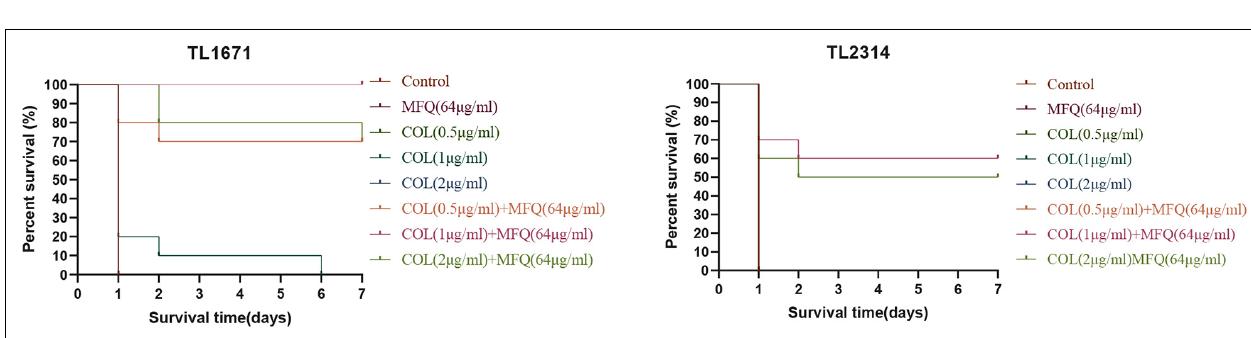
FIGURE 4 | Scanning electron microscopy image. TL2314 was selected as the experimental strain. (A) : LB broth control group, 3000 × ; (B) : LB broth control group, 7000 × ; (C) : mefloquine single group, 3000 × ; (D) : mefloquine single group, 7000 × ; (E) : colistin single group, 3000 × ; (F) : colistin single group, 7000 × ; (G) : mefloquine combined with colistin group, 3000 × ; (H) : mefloquine combined with colistin group, 7000 × . Mefloquine (MFQ) and colistin (COL).